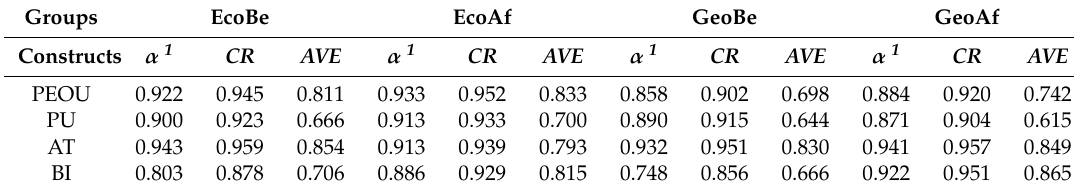
Table 3. Constructs’ reliability and